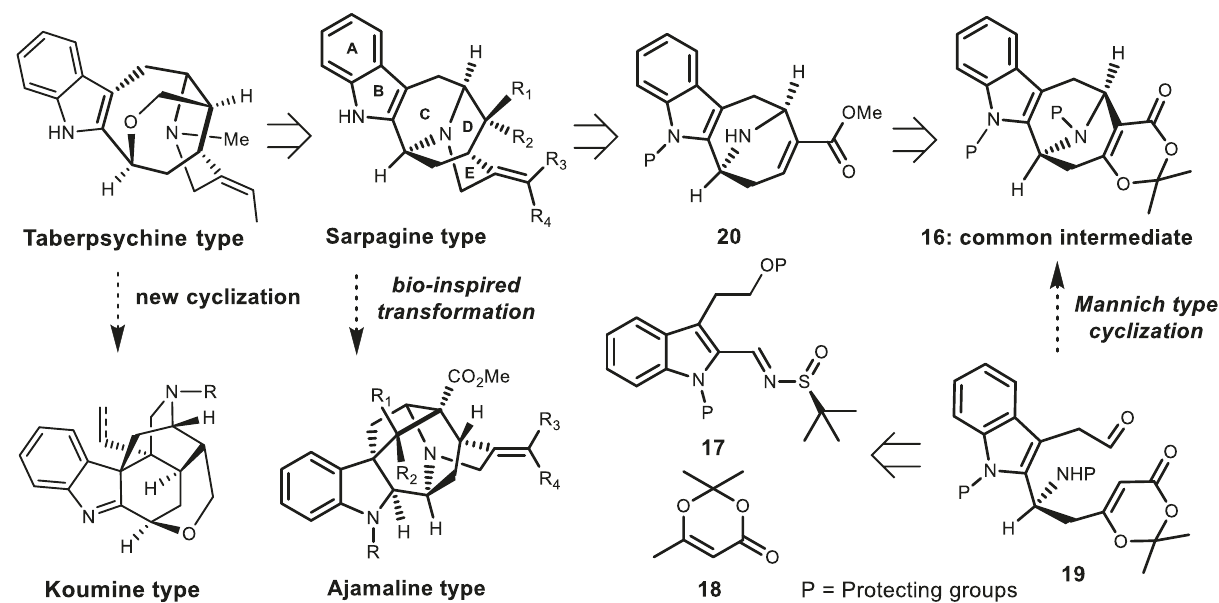
Fig. 2 Retrosynthetic analysis based on amide-mediated Mannich-type cyclizations. The collective synthesis of sarpagine-ajmaline-koumine type alkaloids are based on common intermediate 16